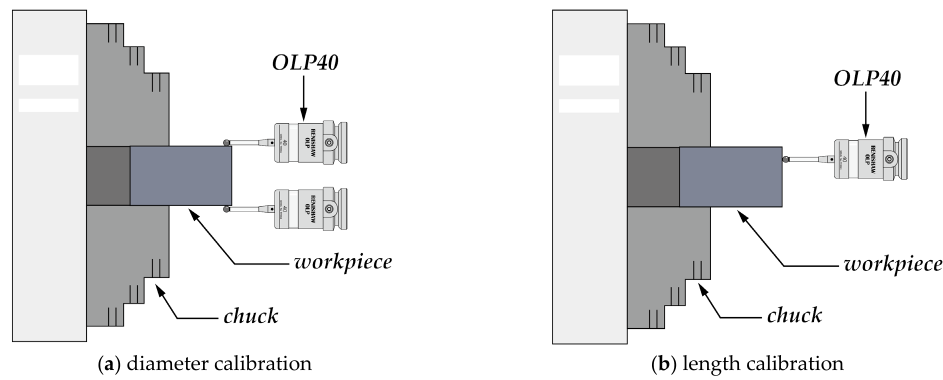
Machines 2021 , 9 , x FOR PEER REVIEW Figure 6. ( a ) Diameter and ( b ) length calibration schematic diagram. Figure 6. ( a ) Diameter and ( b ) length calibration schematic diagram.